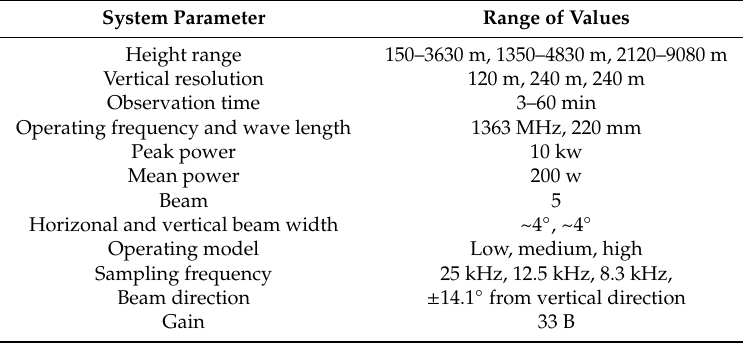
Table 2. Performance characteristics of the wind-profile